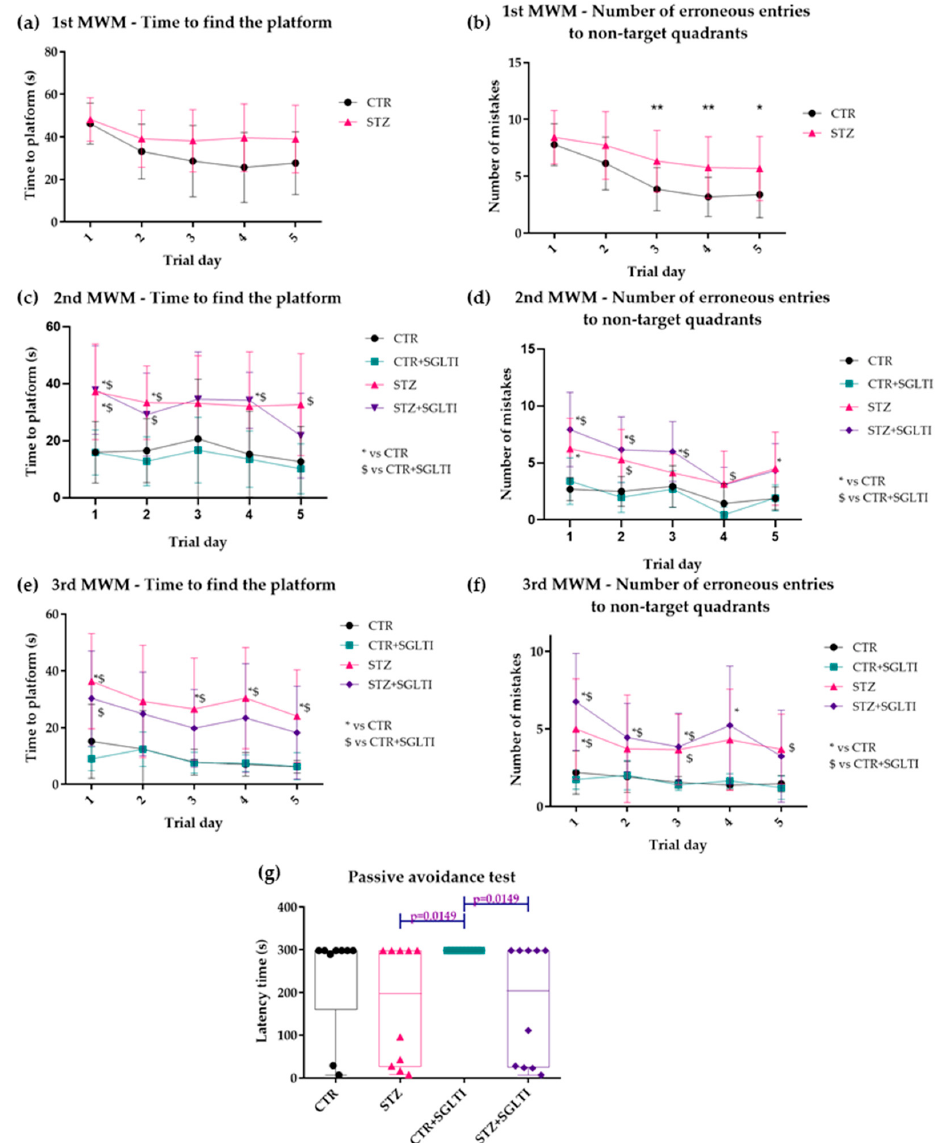
Figure 3. Cognitive assessment by Morris water maze (MWM) and Passive Avoidance (PAT) tests.